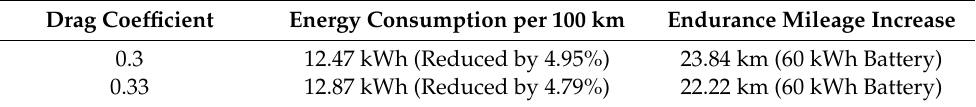
Table 6. Endurance Mileage Increase using SiC Inverters under Different Drag Coefficient.